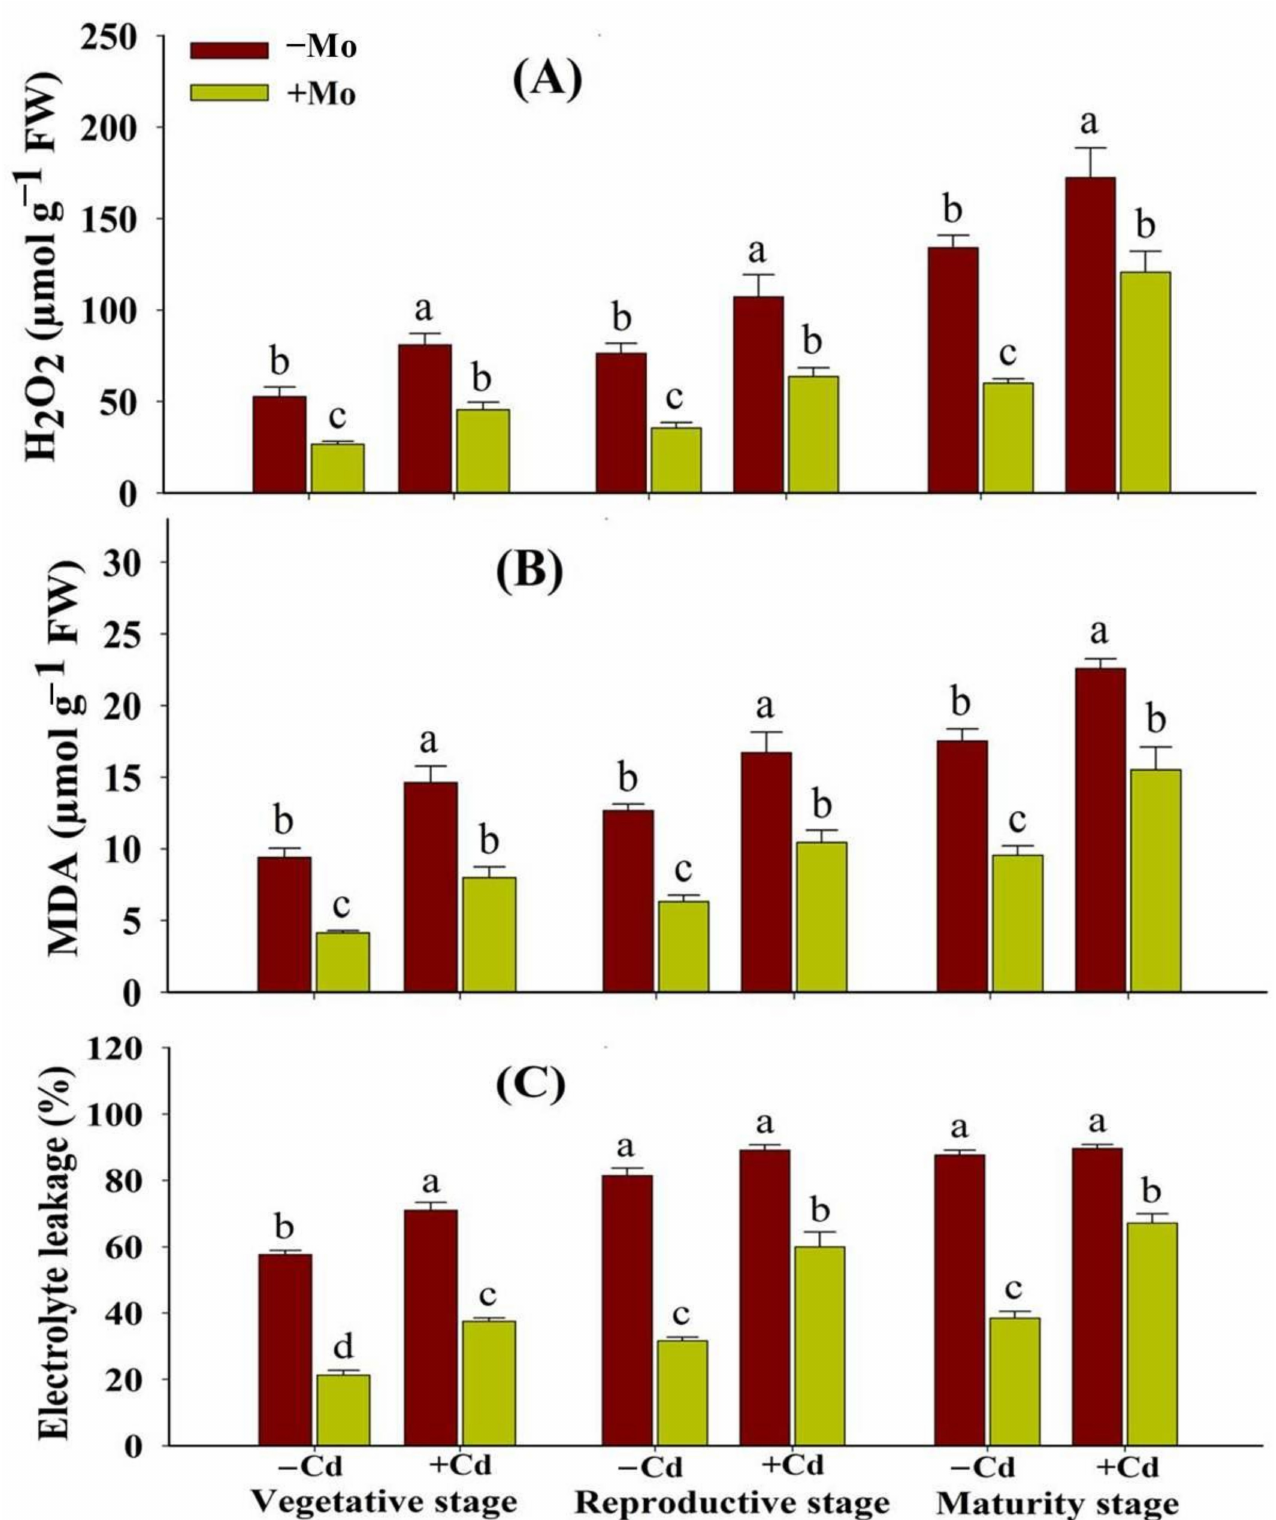
Figure 4. Effect of Mo supply and Cd toxicity on hydrogen peroxide (H 2 O 2 ) content ( A ), malondialdehyde (MDA) (B), and electrolyte leakage (EL) ( C ), in leaves of aromatic rice ‘Xiangyaxiangzhan’ cultivar, at the vegetative, reproductive, and maturity stages. Bars above means indicate ± S.E. of four independent replicates ( n = 4) and different small alphabetical letters above means reveal significant differences among treatments within a particular growth stage according to the LSD test ( p <